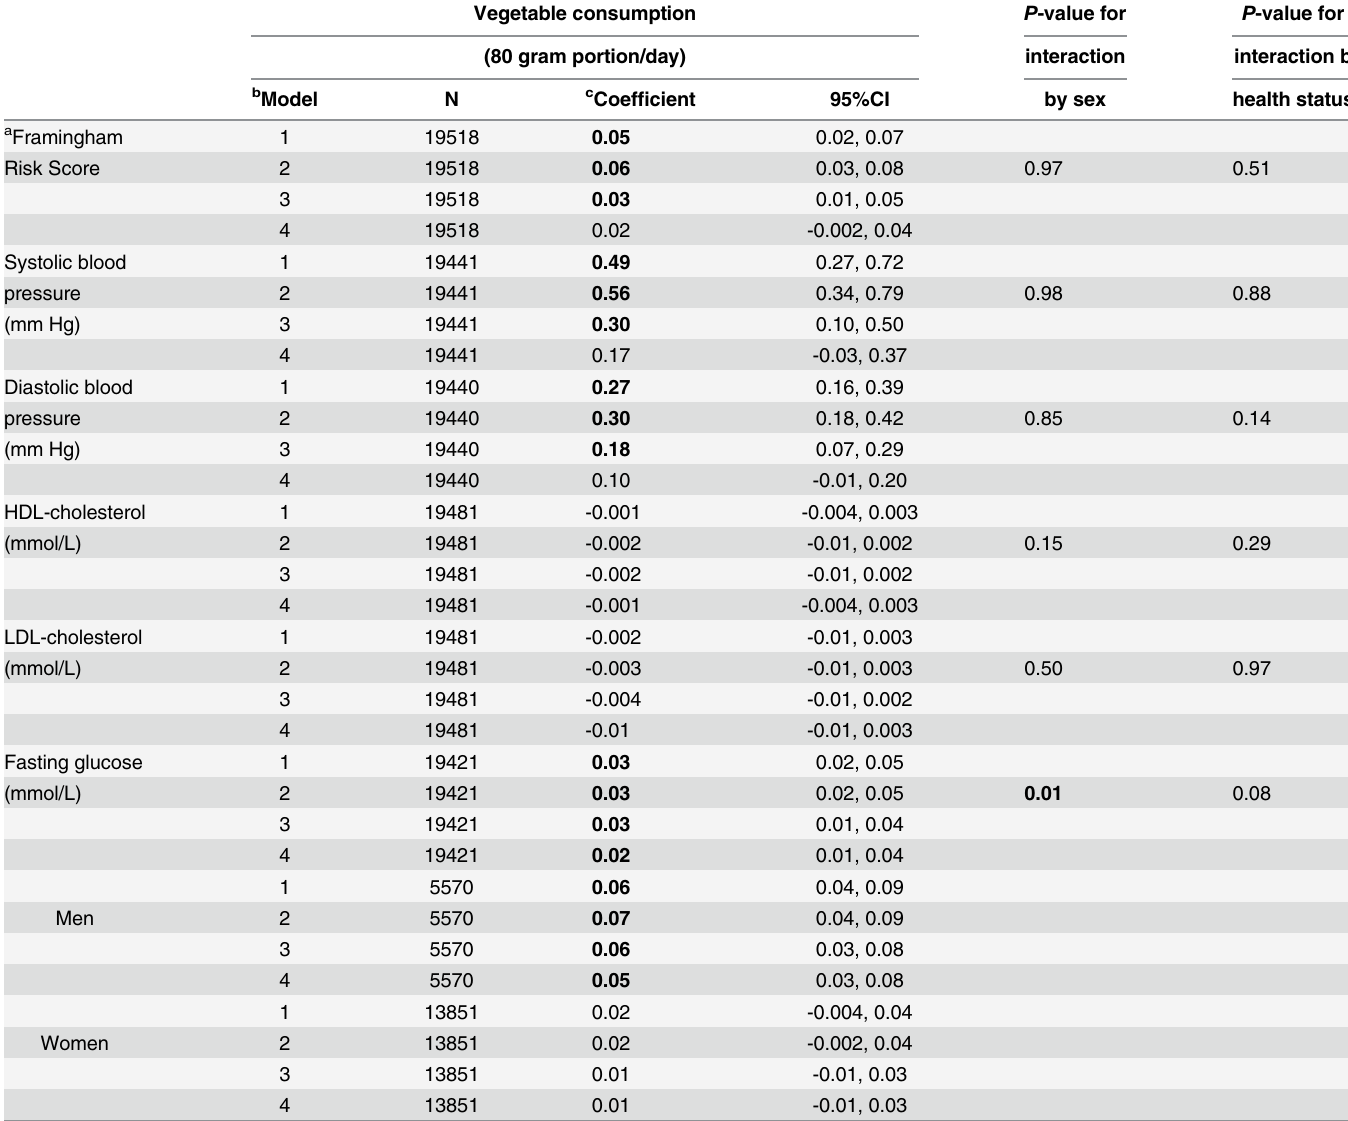
Table 3. Adjusted Associations of Vegetable Consumption with Framingham Risk Score and CVD Risk Factors after Multiple Imputation in Older Chinese in Phases 1 and 2 of the Guangzhou Biobank Cohort Study, 2003 –